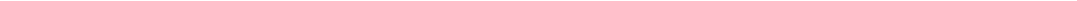
Fig. 4 Snail in fl uences mTOR/4E-BP1-controlled translation and polysome formation. a , b Snail-expressing a or -knockdown b cells and their respective controls were transfected with a bicistronic luciferase reporter that detects cap-dependent translation of the Renilla luciferase gene and cap-independent translation of the fi re fl y luciferase gene. After 24 h, cells were treated with mTOR kinase inhibitors AZD8055 (100 nM), INK128 (100 nM), or DMSO for 12 h, followed by measurement of luciferase activities. The ratio of Renilla / fi re fl y luciferase activities was calculated and presented as a percentage of the cap- dependent translation activity found in the DMSO-treated control cells. c Cap-dependent translation analysis of Snail wild-type (WT) and knockout (KO) HCT116 cells expressing 4E-BP1 shRNA or control shRNA treated with 100 nM INK128 for 12 h. d , e Snail-expressing T47D cells d or Snail-knockdown HCT116 cells e and their respective controls were treated with 100 nM AZD8055, 100 nM INK128, or DMSO for 12 h. Cell lysates were precipitated with m 7 GTP sepharose beads or immunoprecipitated with eIF4E antibody followed by western blot analysis for the indicated proteins. f – i Snail-expressing or vector control MCF7 cells f , g and Snail WT or KO HCT116 cells h , i were treated with 100 nM INK128 or DMSO as control for 12 h, followed by polysome analysis. The vertical blue line separates the polysomal (P) and monosomal (M) fractions. The P/M ratio, an index of translational ef fi ciency, was calculated by comparing areas under the polysome and monosome peaks using NIH image J. The results are expressed as a percentage of the P/M ratio relative to the DMSO-treated vector g or Snail WT i controls. j , k Nascent protein synthesis was measured for Snail-expressing or vector control T47D cells j and Snail WT or KO HCT116 cells k treated with 100 nM INK128 or DMSO for 12 h. The results are expressed as a percentage of methionine analog incorporation relative to the DMSO-treated control cells. All graphic data are presented as mean ± SEM ( n = 3 technical replicates per condition). * P < 0.01; # P < 0.001; NS, not signi fi cant using Student ’ s t